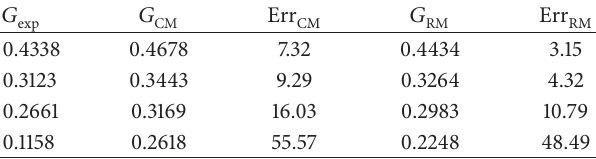
Figure 10: Flows paths at mass flow 0.3 kg/s, first-order upwind and second-order central discretization. Table 3: Results of mass flow rate in the inlet for unsteady